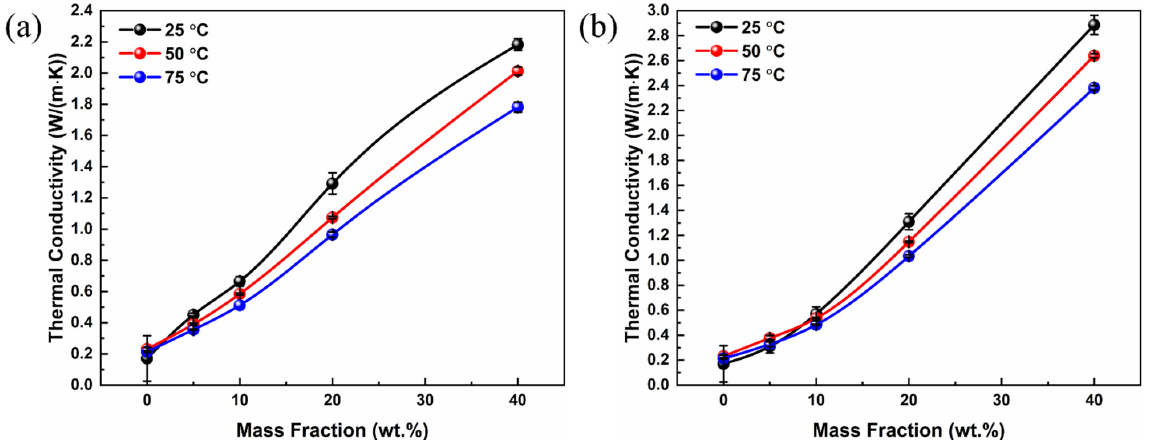
Figure 4. Variations of the thermal conductivity of PVDF/CF composites at different temperatures versus the content of CFs: ( a ) PVDF/CF and ( b ) PVDF/SCF composite series.